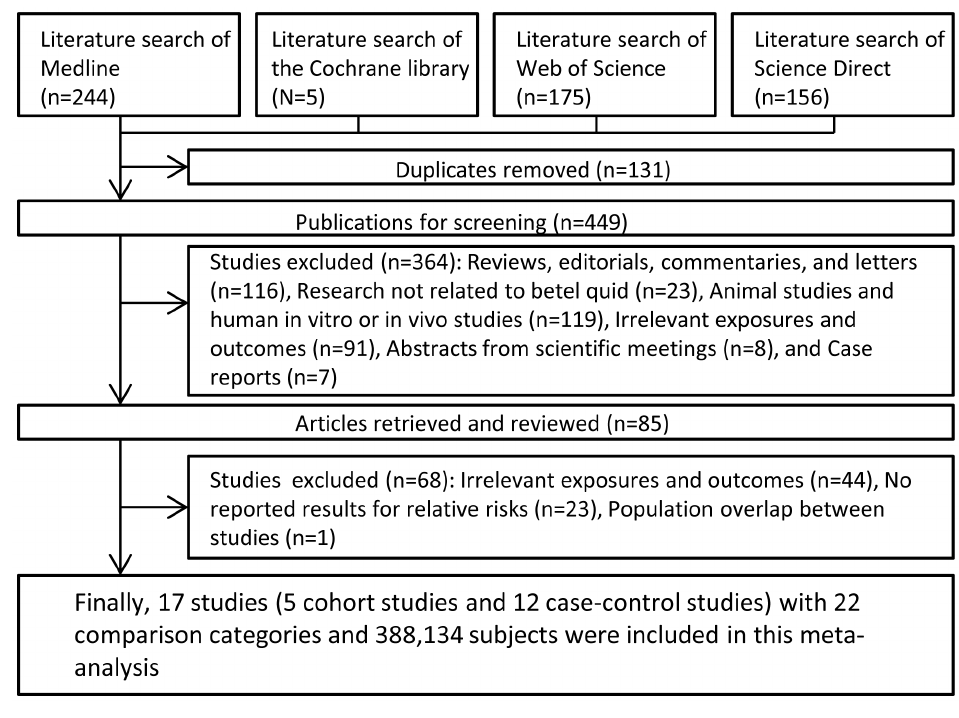
Figure 1. Flow diagram of study selection.